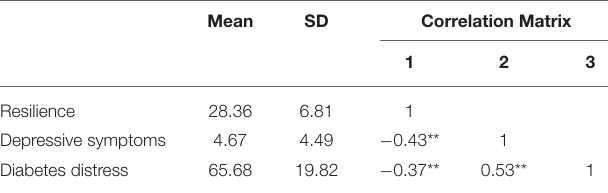
TABLE 2 | Levels and associations of parental resilience with parental depressive symptoms and diabetes